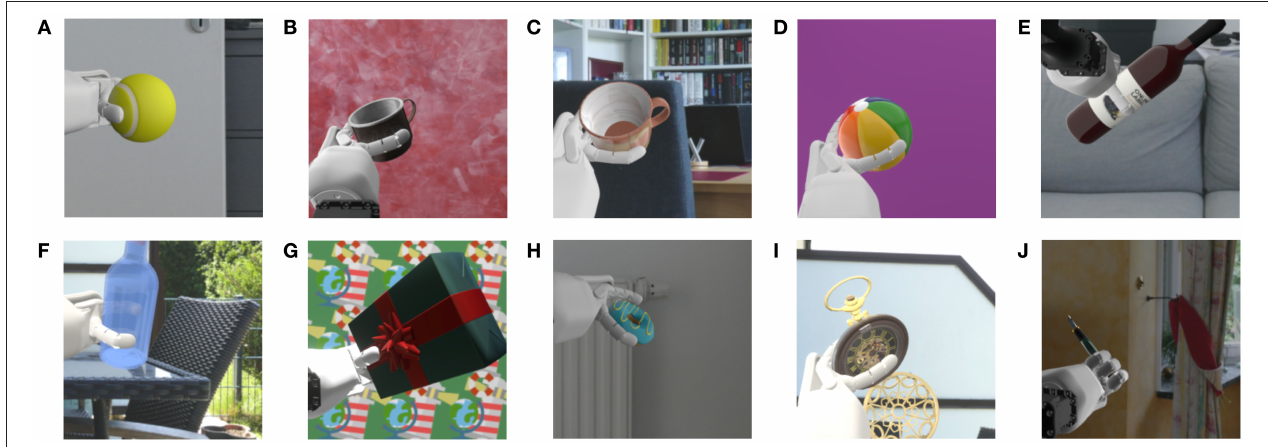
FIGURE 4 | This figure presents 10 example images of the dataset captured from the moving camera’s perspective. Ten objects are shown in front of different backgrounds with different lighting conditions. Additionally, NICO is holding the objects in different positions. (A) 3D model of “Tennis ball” by “tr3vinj”, (B) “Metal Cup” by “Warkarma”, (C) “Mug” by “Kristijan Zecevic”, (D) “Beach Ball” by “Tommyleenev”, (E) “3D Wine Bottle Model” by “Johana-PS”, (F) “Glass Bottle” by “Aullwen”, (G) “Gift - 3December” by “zhixson”, (H) Derivative of “Coffee and donuts” by “Ivan Dnistrian”, (I) Derivative of “Antique Pocket Watch” by “michael_grodkowski”, and (J) Derivative of “Fountain Pen” by “Etherlyte”. All 10 models are used under CC BY 4.0 and also licensed under CC BY